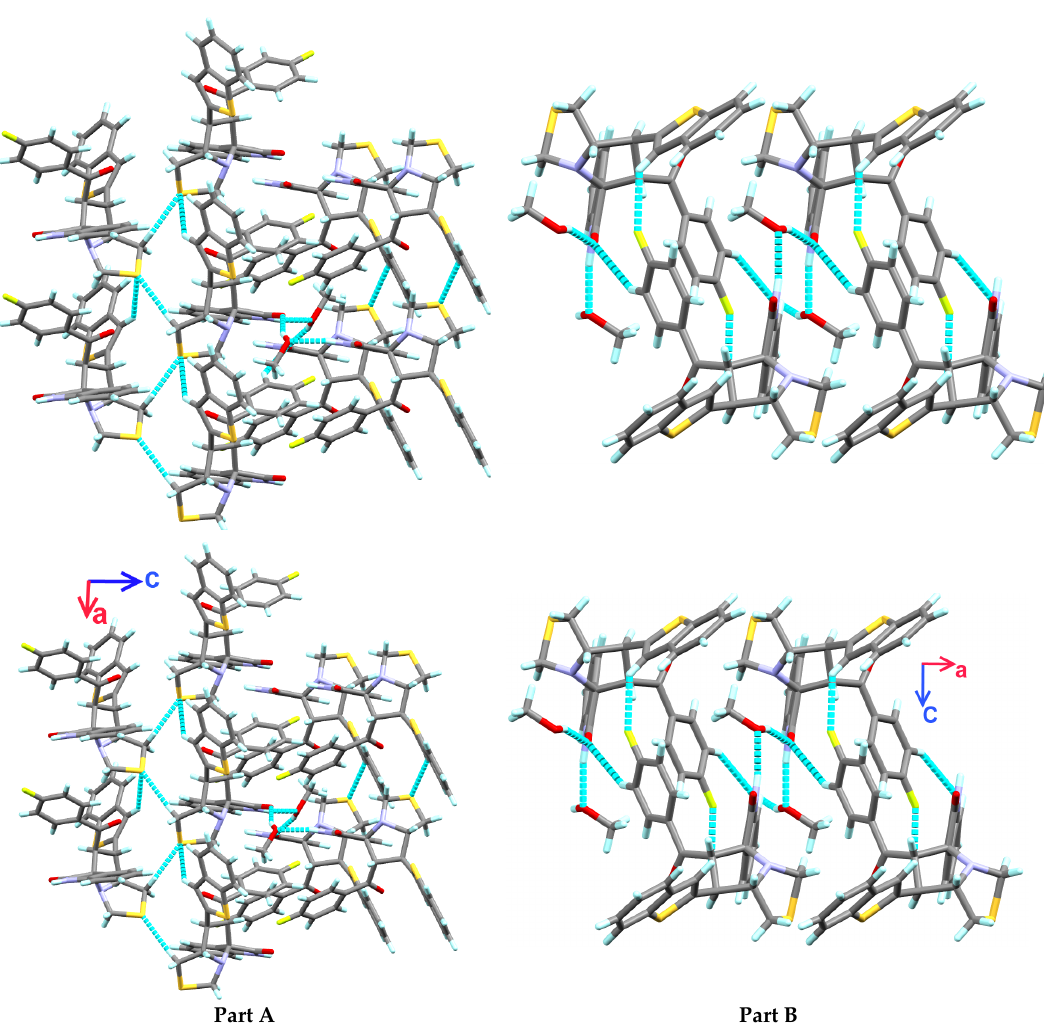
Part A Part B Figure 3. Crystal packing diagram of conformers A and B of 5 . The turquoise dotted lines represent the N-H ... O, O-H ... O, C-H ... F, C-H ... S and C-H...O intermolecular Table 2. Hydrogen bond distances (Å) and angles (°) in 5 .